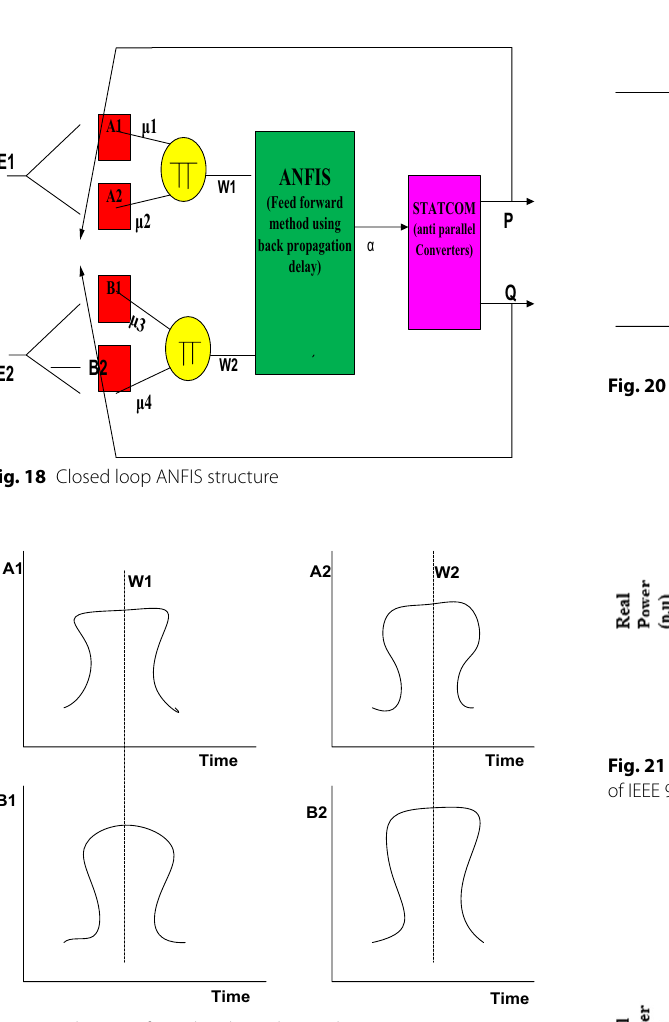
Fig. 19 Selection of weights through sampling